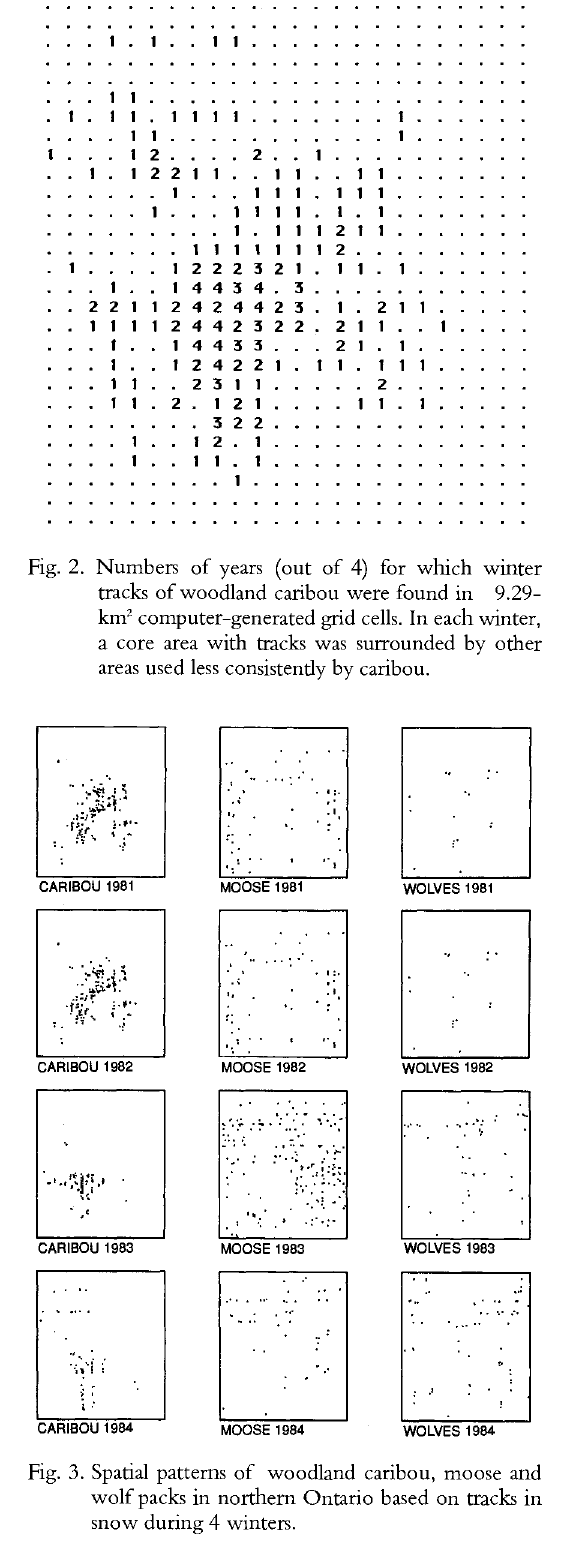
Fig. 3. Spatial patterns of woodland caribou, moose and wolf packs in northern Ontario based on tracks in snow during 4 winters.